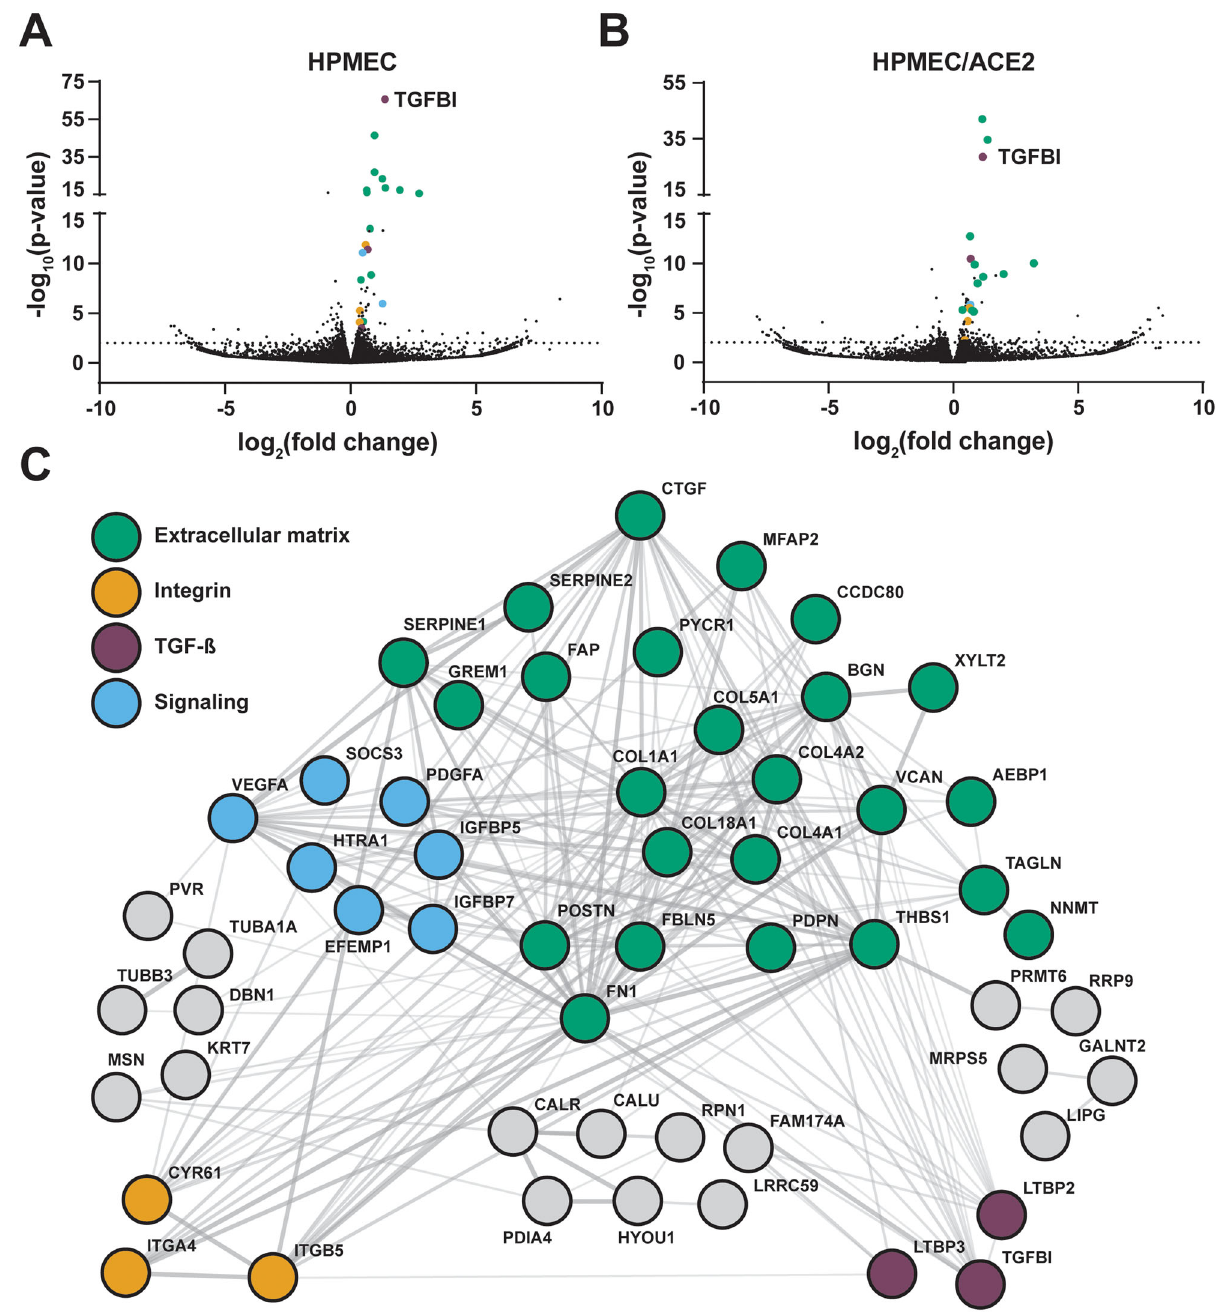
Fig. 5 | RNA-Sequencing analysis of SARS-CoV-2 S-treated HPMEC and HPMEC/ ACE2. A A volcano plot of differentially expressed genes (DEGs) detected in HPMECs treated with 10 µ g/mL of SARS-CoV-2 S at 24 hpt. B Same as A but dis- playingDEGsfromHPMEC/ACE2treated with10 µ g/mLSARS-CoV-2S.Dottedlines